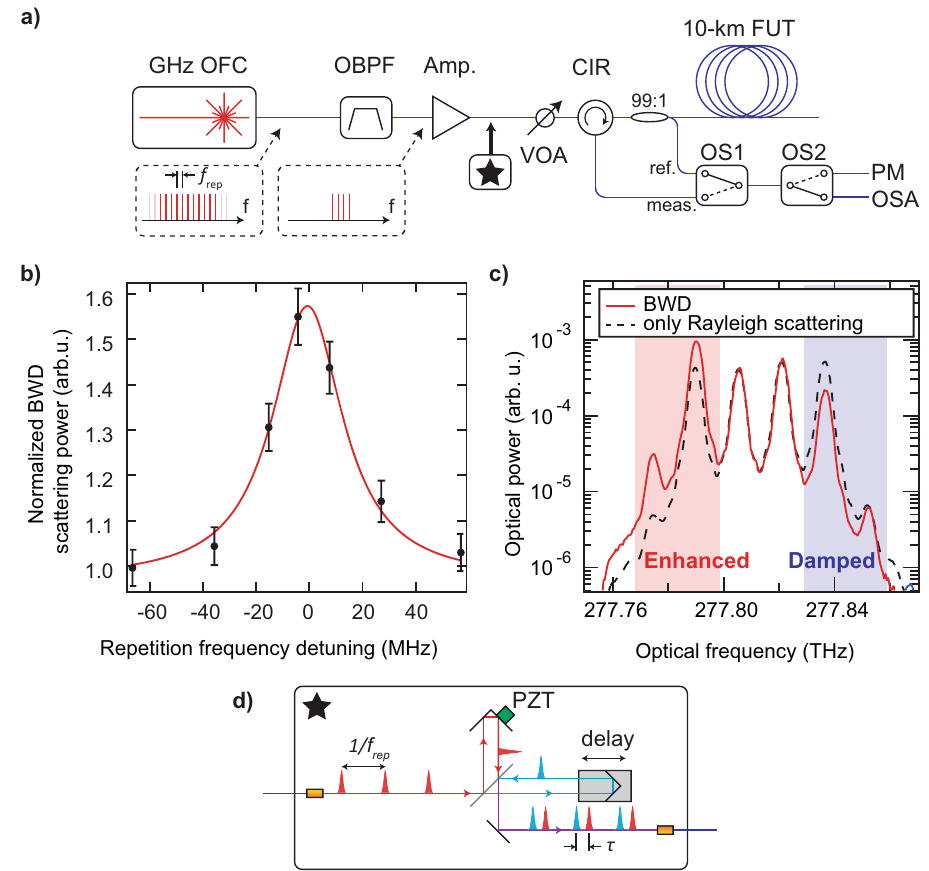
Fig. 2 Experimental apparatus and results. a Experimental apparatus. GHz OFC: optical frequency comb based on a Yb:Y 2 O 3 ceramic Kerr-lens mode- locked laser with repetition rates of 7.8 or 15.6 GHz. OBPF: optical band-pass fi lter based on a grating spectrometer with resolution of 2 GHz. Amp.: Three- stage optical ampli fi er (composed of one semiconductor optical ampli fi er and two ytterbium-doped fi ber ampli fi ers). VOA: variable optical attenuator. CIR: optical circulator. OS: optical switch. FUT: fi ber-under-test. OSA: optical spectrum analyzer with resolution of 4 GHz. PM: optical power meter. The black star: the part to be added in the next experiment (see ( d )). b BWD power (corresponding to the phonon amplitude) as a function of the repetition rate detuning, measured using an input power of 20 mW. The red trace shows the Lorentzian fi tting of the black experimental data points. The error bars represent one standard deviation from the mean value. c BWD spectra at the repetition rate of 15.57 GHz. Black dashed line: Rayleigh scattering used as the reference; red solid line: BWD spectrum. The red and blue shaded areas correspond to the Brillouin gain and loss in Fig. 1f, respectively. d Michelson interferometer used in the double pulse experiment at the black star in a . PZT: piezo-actuator used for scanning of the arm ’ s